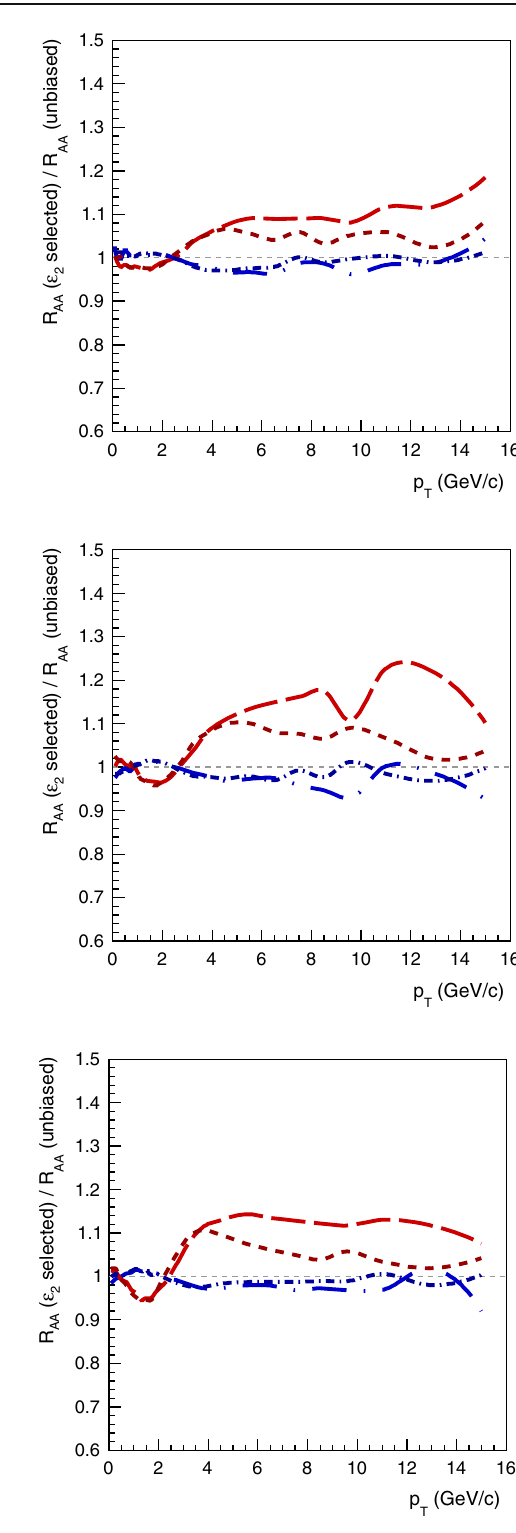
Fig. 10 The nuclear modification factor R AA of charmed hadrons in the 0–10% (top), 10–30% (middle) and 30–50% (bottom) most central √ s NN = 5 . 02 TeV. Results for the 20% highest- (cid:7) 2 Pb–Pb collisions at